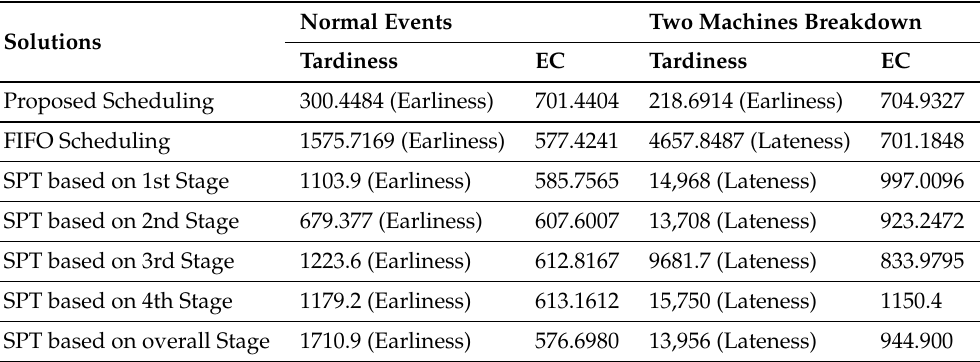
Table 3. Comparison of the implemented scheduling